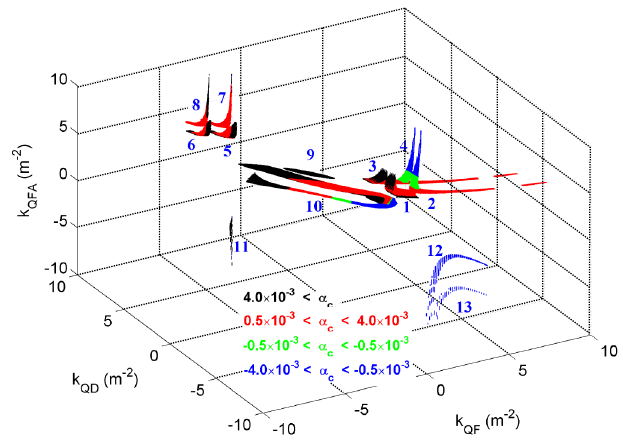
FIG. 4. (Color) Momentum compaction of all linear stable so- lutions in plotted k -space for one of the 12 ALS TBA sectors.